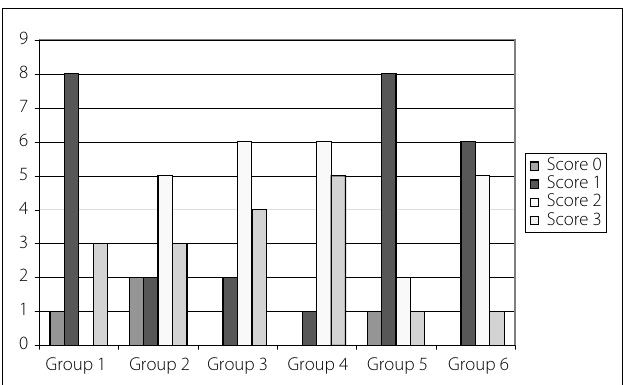
Figure 1. ARI scores.